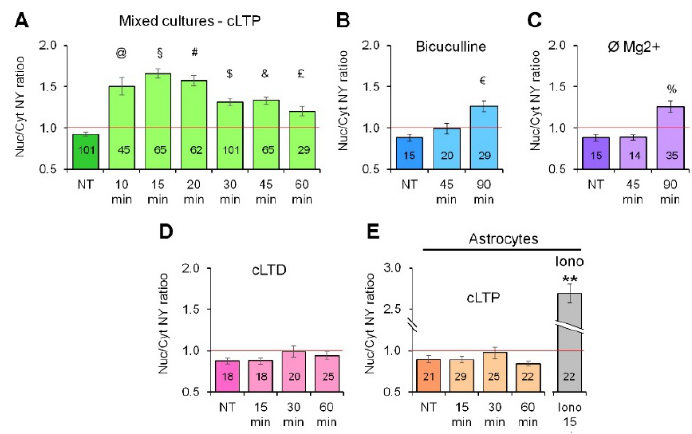
Figure 3. Quantification of NY Cyt/Nuc ratio after cLTP induction. ( A ) Time-course quantification of